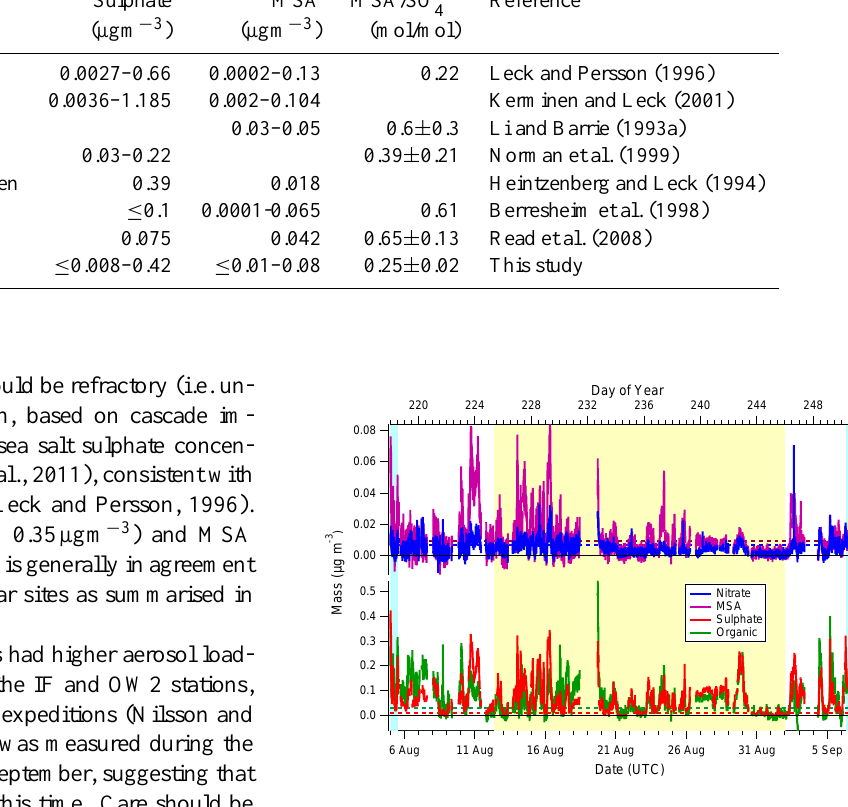
Fig. 2. Organic, sulphate, methane sulphonate (MSA) and nitrate mass concentrations (solid lines) and detection limits (dashed lines) during ASCOS. Blue, yellow and gray regions represent marginal ice zone (MIZ), ice floe (IF) and open water stations (OW), respec-